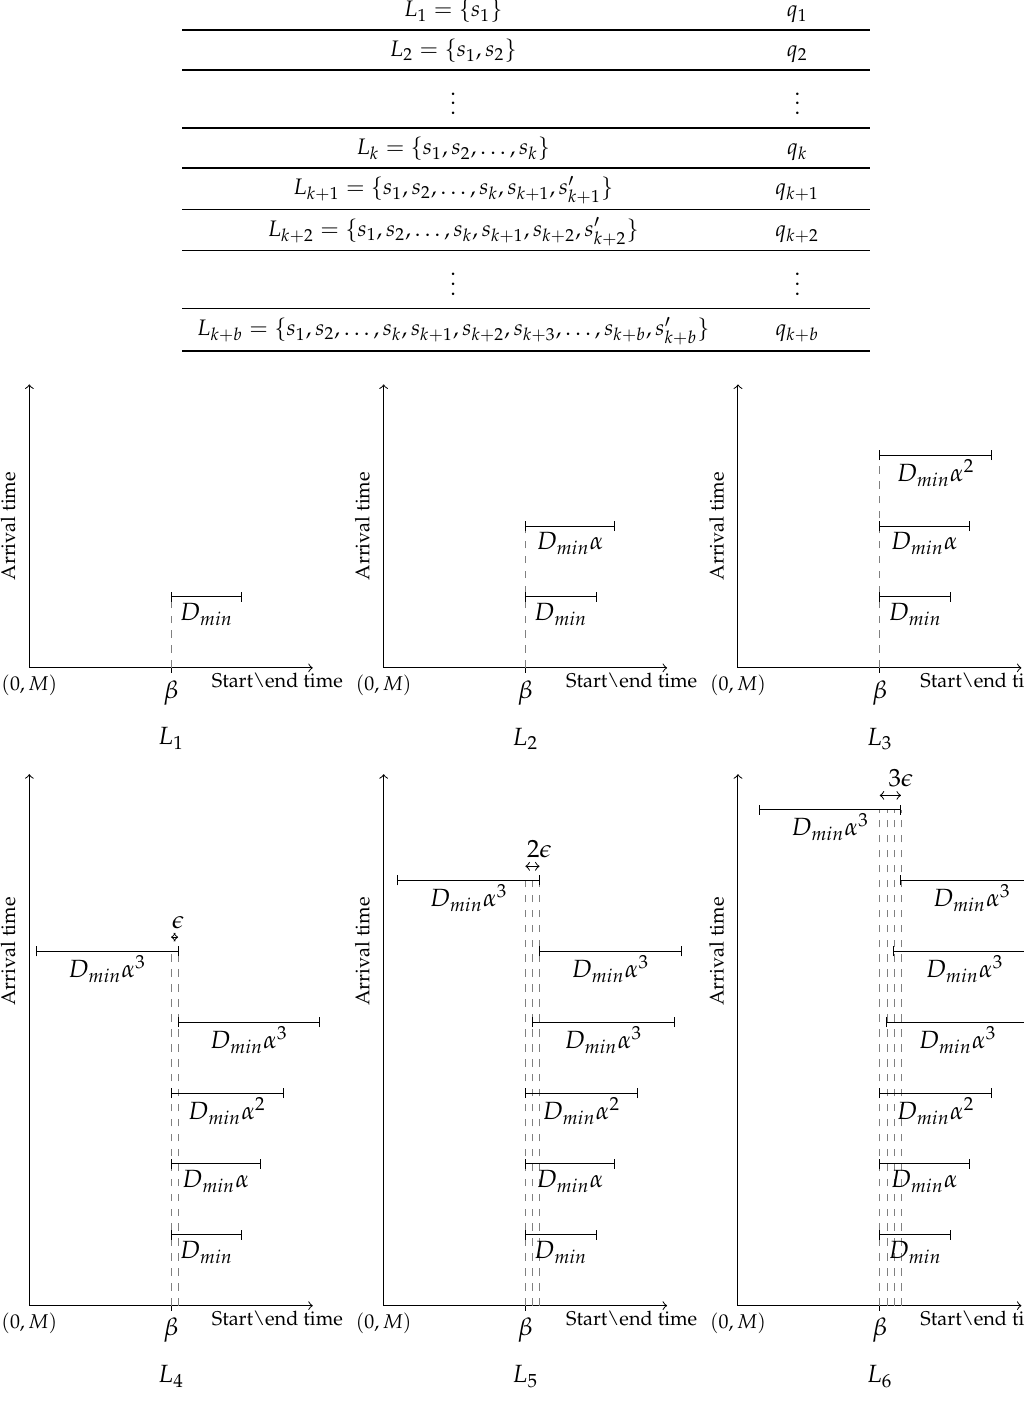
Figure A1. L 1 , L 2 , . . . , L k + b when b = k = 3 and n = 1. M > 0 is a very large real